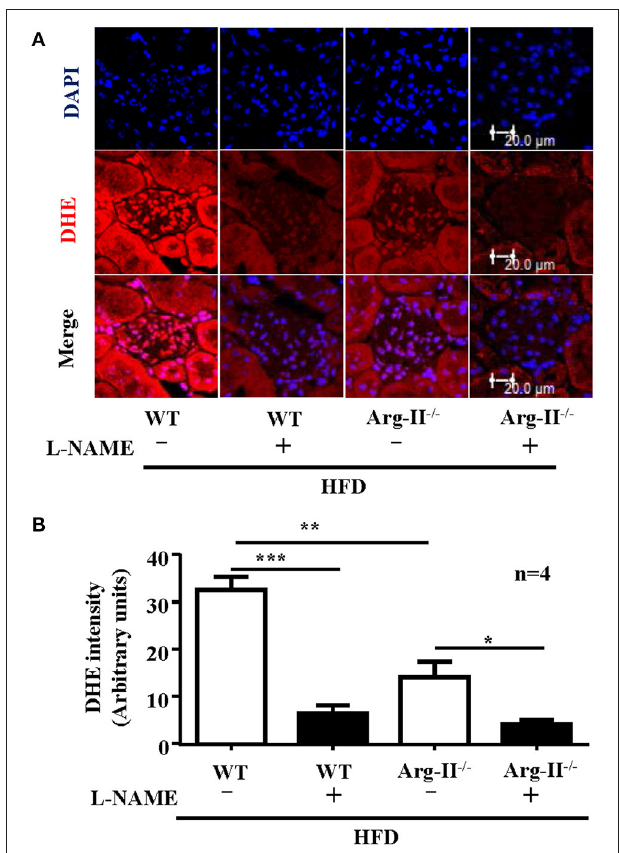
FIGURE 5 | Arg-II-deficiency decreases renal ROS production in obesity. (A) Immuno-fluorescence confocal microscopy showing O − 2 level in glomerulus detected by DHE staining (red). Kidney cryosections were pre-treated with or without NOS inhibitor L-NAME (1 mmol/L, 1 h) prior to the DHE staining. Nuclei were counter stained by DAPI (blue). (B) Bar graphs show quantification of DHE signals. n = 4, * p < 0.05, ** p < 0.01, *** p < 0.001 between the indicated